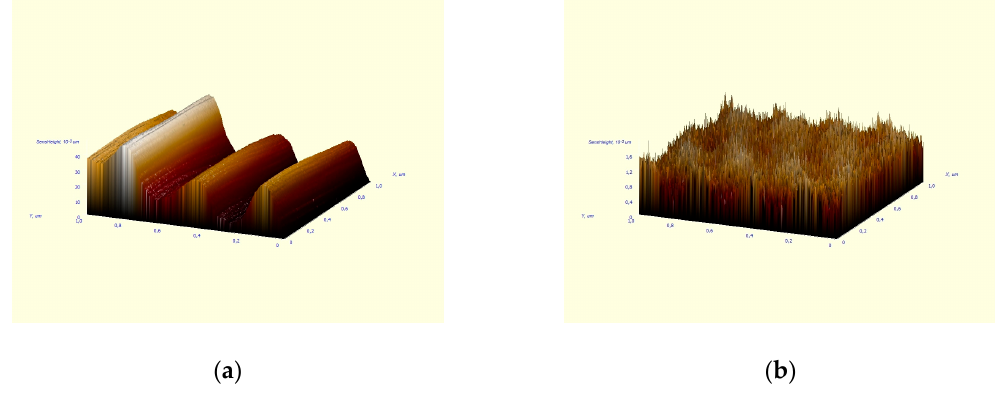
Figure 5. KBr substrates: pure ( a ) and covered with the CNTs ( b ).